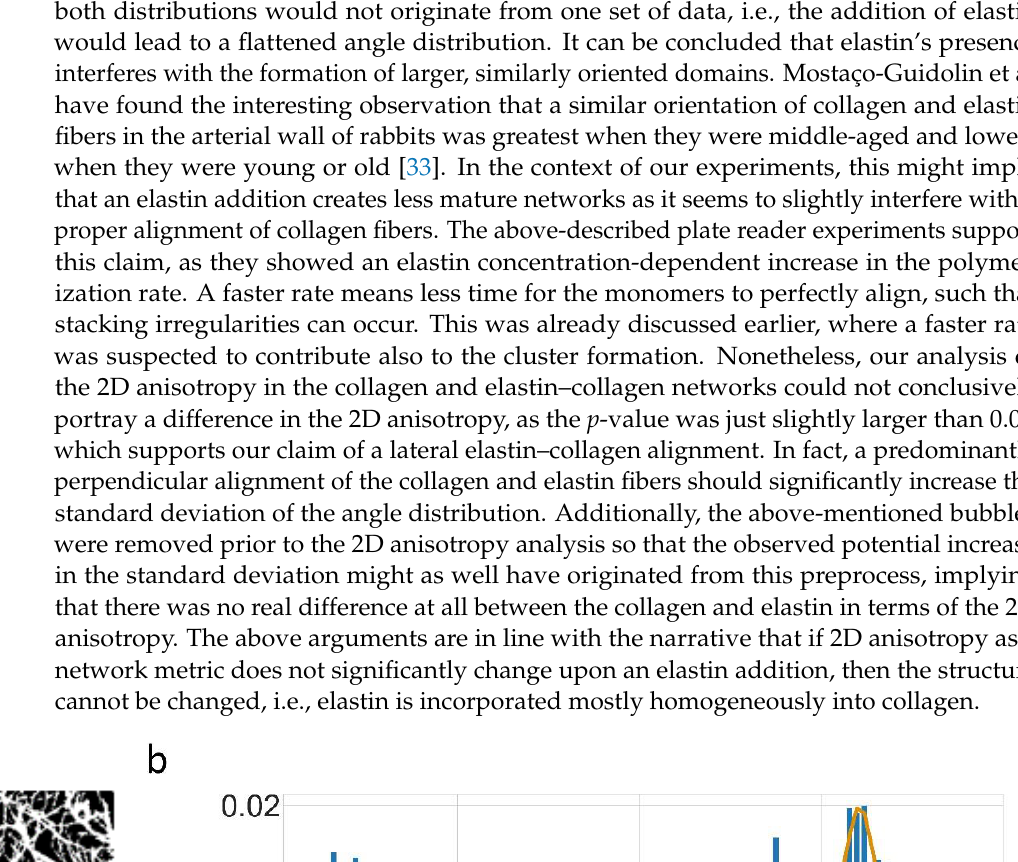
Figure 4. ( a ) Polar plot of the 2D anisotropy analysis of each 10 random positions in one 2 mg/mL collagen network and one collagen – elastin (33.3 w% elastin) network. The coordinates refer to the determined angle (polar angle) and the standard deviation (radial length) while the circles refer to the median values of the distributions of the standard deviations, i.e., elastin increases the standard deviation of the network and, thereby, the 2D anisotropy. ( b ) Comparison between the standard deviation of the angle distribution of the samples already displayed in Figure 4. Significance was tested with the Mann –Whitney U test. This standard deviation is referred to as “2D anisotropy”. 3.5. Laser Scanning Microscopy (LSM) LSM recordings of a collagen – elastin hydrogel with primary collagen antibody staining support the above claims of lateral collagen – elastin polymerization (Figure 5).